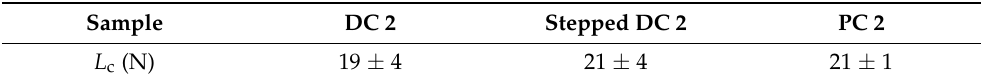
Table 4. Critical normal force L c .